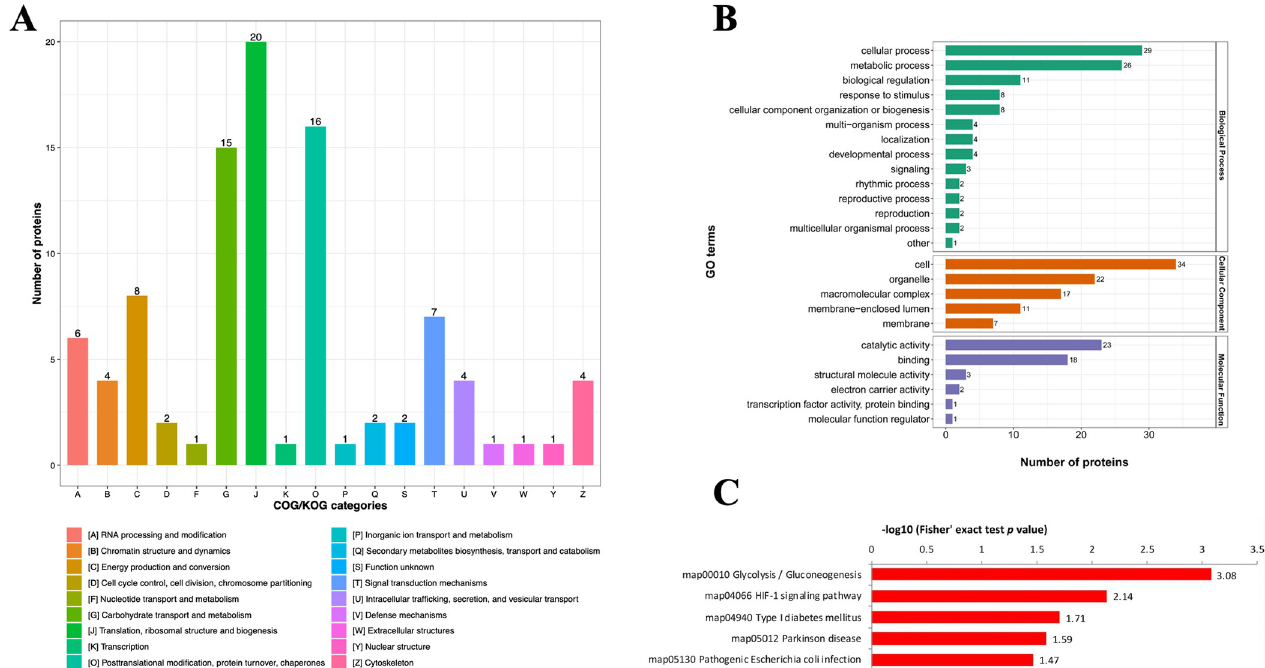
Fig 5. Functional enrichment analysis of differentially malonylated proteins in RH vs. VEG strains. (A) COG/KOG analysis of the differentially malonylated proteins. (B) GO classification and (C) KEGG pathway enrichment analysis of the differentially malonylated proteins.